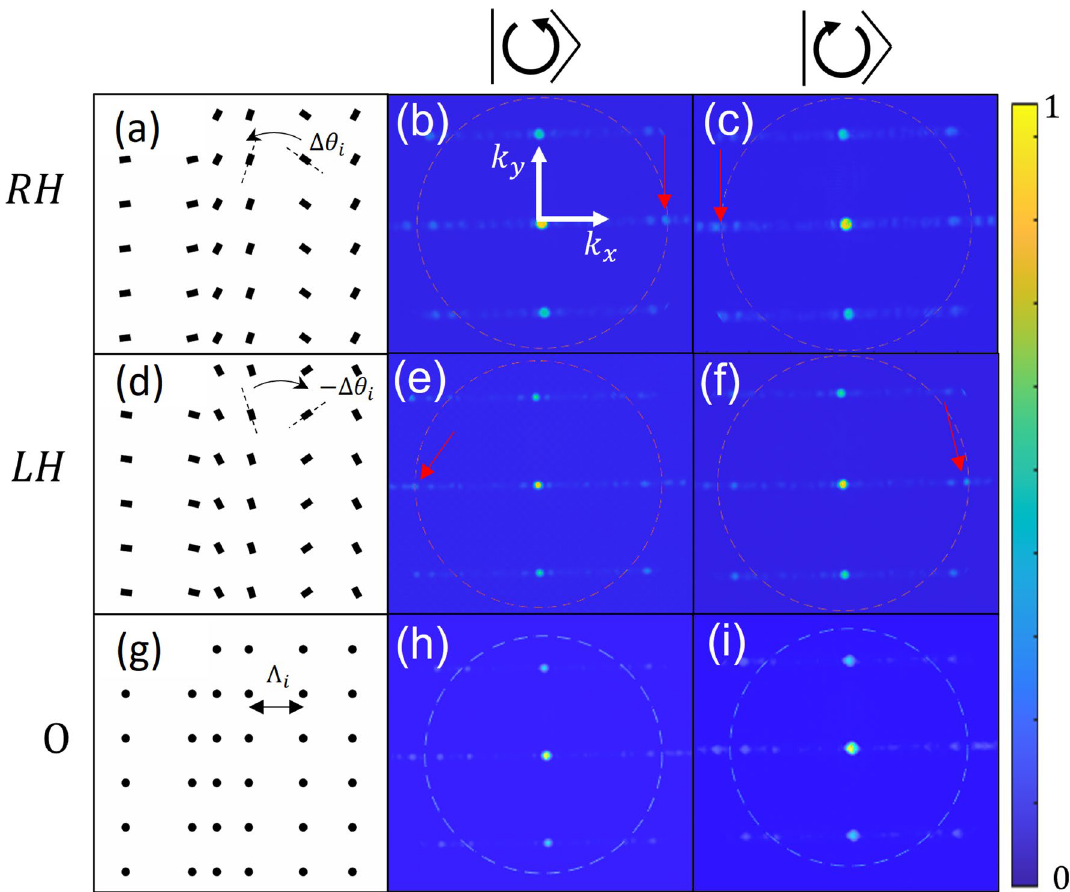
Figure 3. Typical measured k -space distributions for three types of the proposed structures. The structure geometries are shown in ( a , d , g ), ( b , e , h ) are the measured distributions for the incident RCP light and ( c , f , i ) show the corresponding measured intensities for the LCP light. Red arrows denote the location of the TD mode, when present. Gray dotted lines denote the plasmonic momentum k SP . Colorbar on right denotes arbitrary intensity